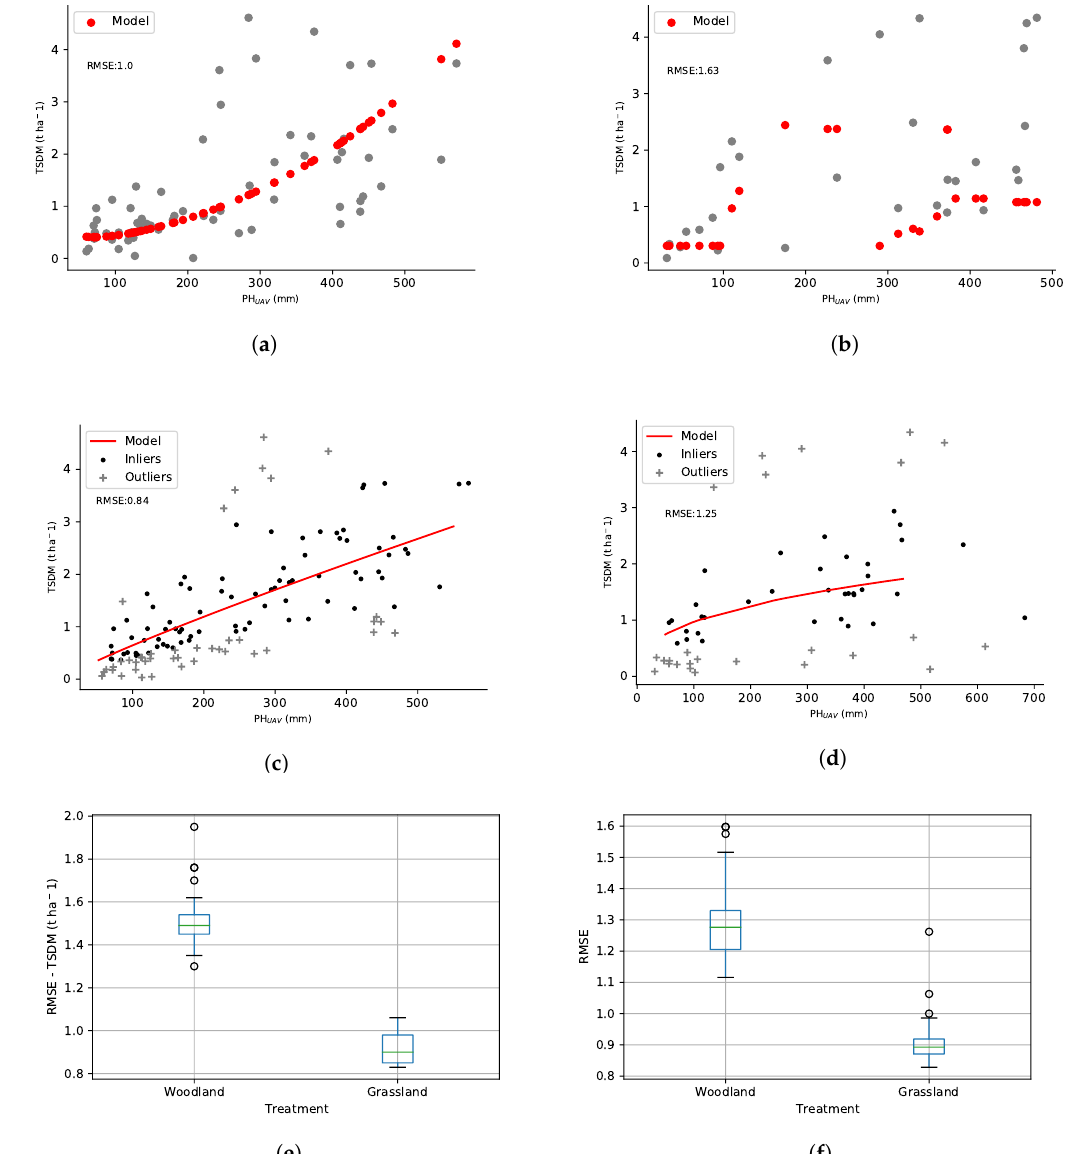
Figure 7. Robust regression and auto ML model results of pasture yield predictions for both the grassland and woodland categories. Auto ML regression model of the grassland ( a ) and woodland ( b ) categories, robust regression model of the grassland ( c ) and woodland ( d ) category and auto ML ( e ) and robust ( f ) regression modelling accuracy assessment